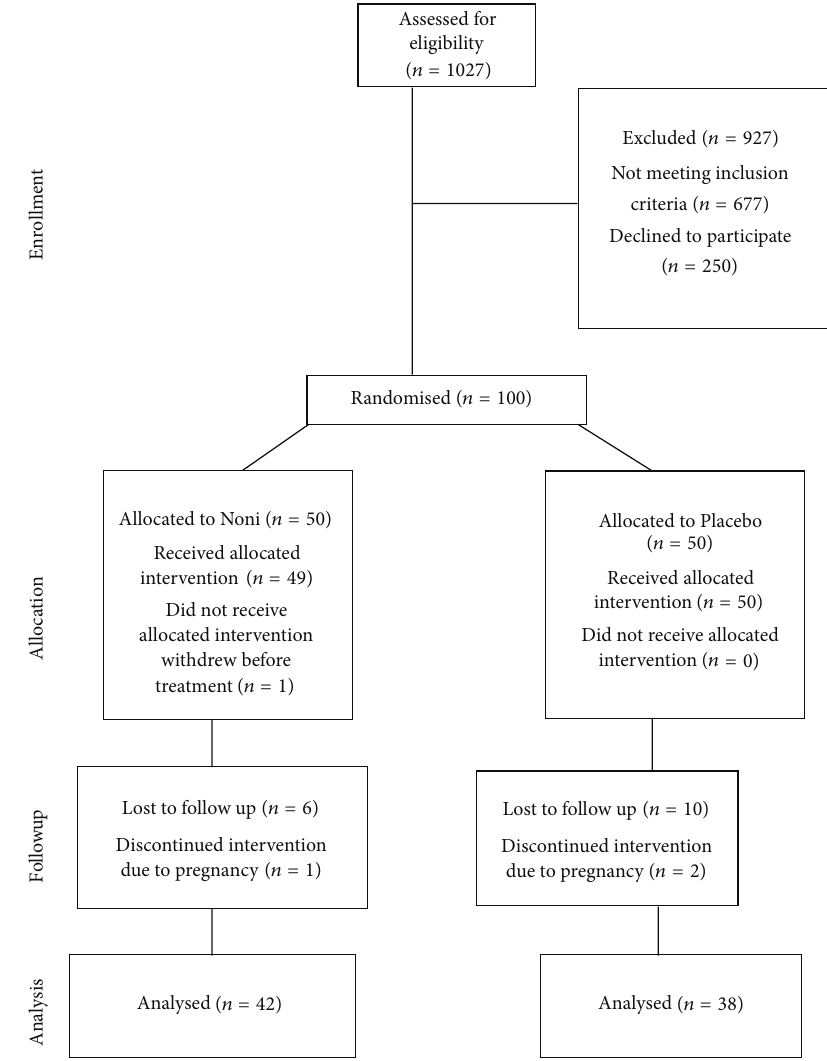
F 1: �articipant �ow